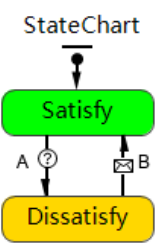
Figure 9. The statechart for support resource agent.